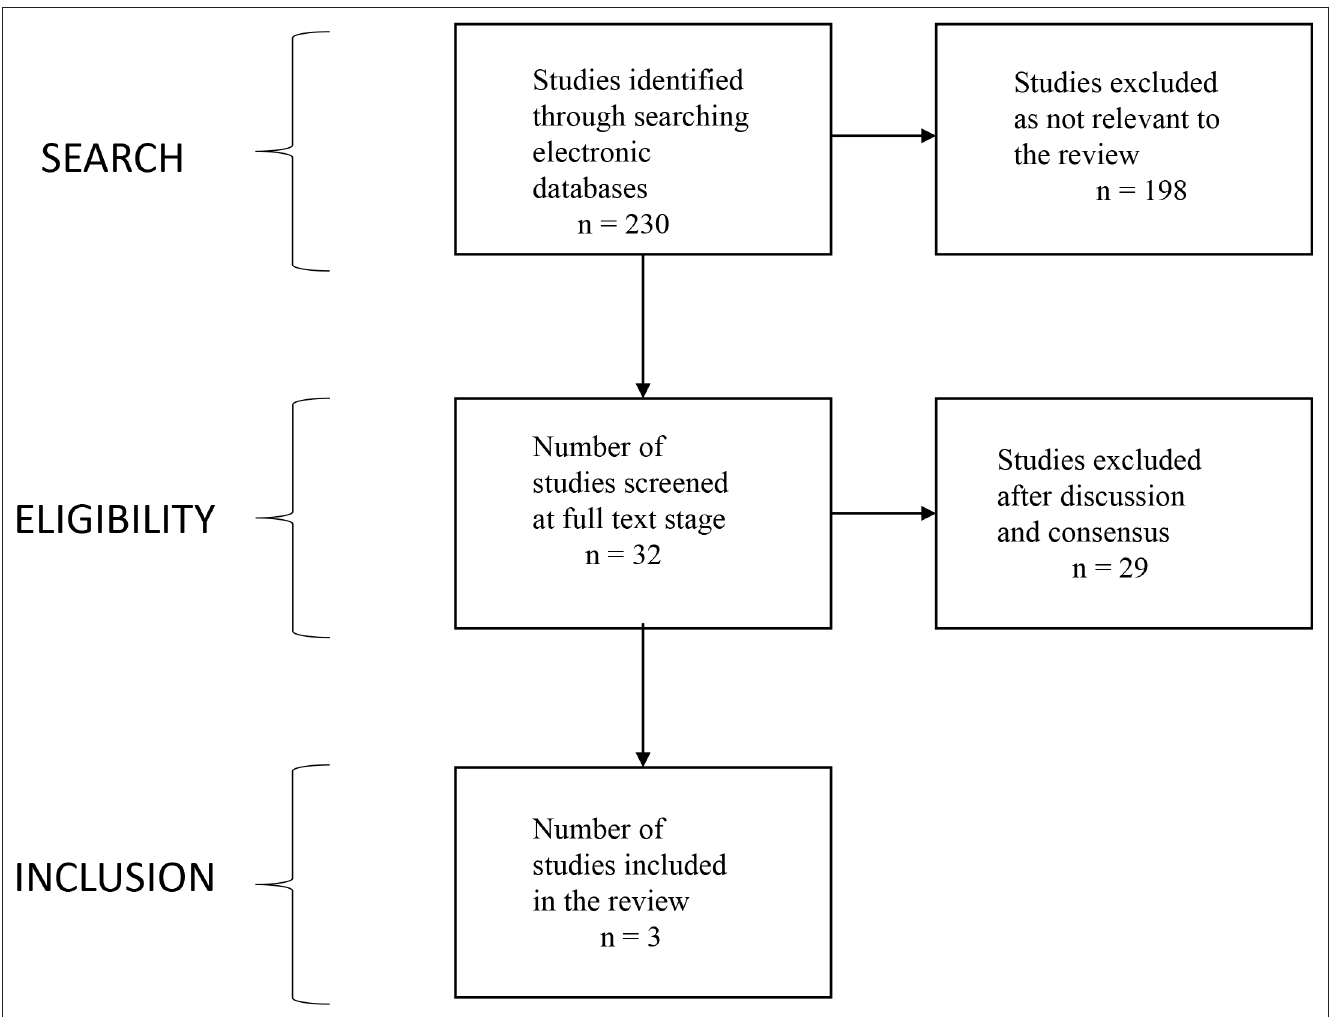
Figure 1 Flowchart showing the process for identification of studies suitable for